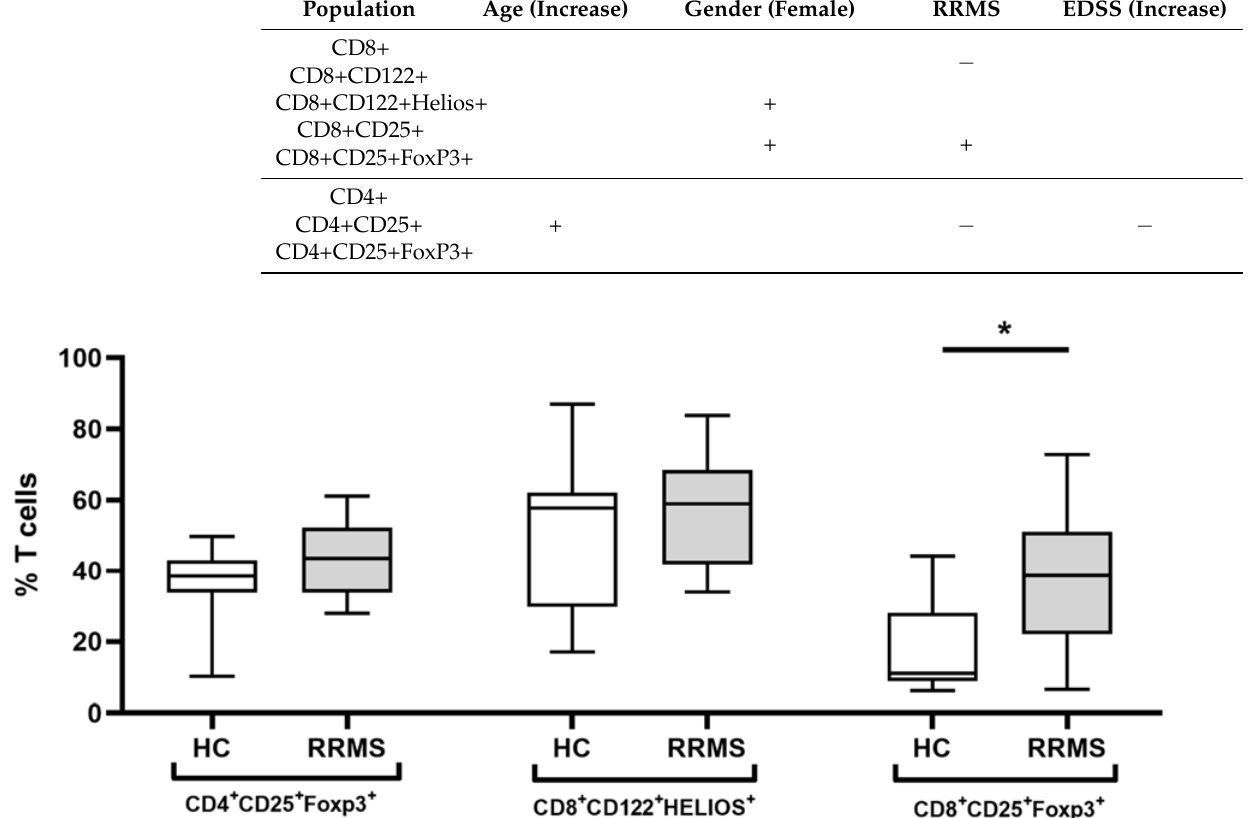
Table 1. Model. Factors that partly explained the variance; p ≤ 0.05. EDSS parameter for RRMS group only; + positive correlation, − negative correlation. Population Age (Increase) Gender (Female) RRMS EDSS (Increase)